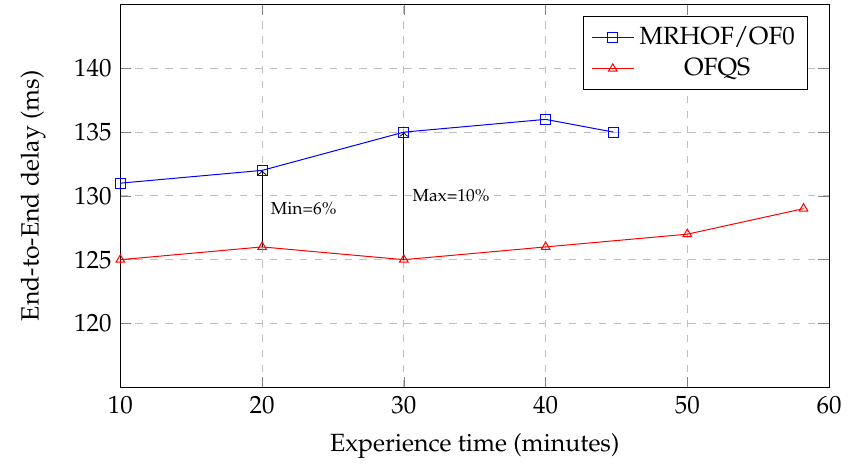
Figure 7. End-to-End delay variation with